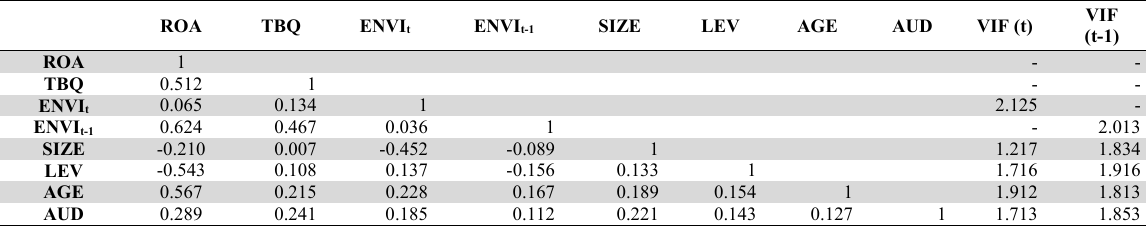
Correlation and Multicollinearity